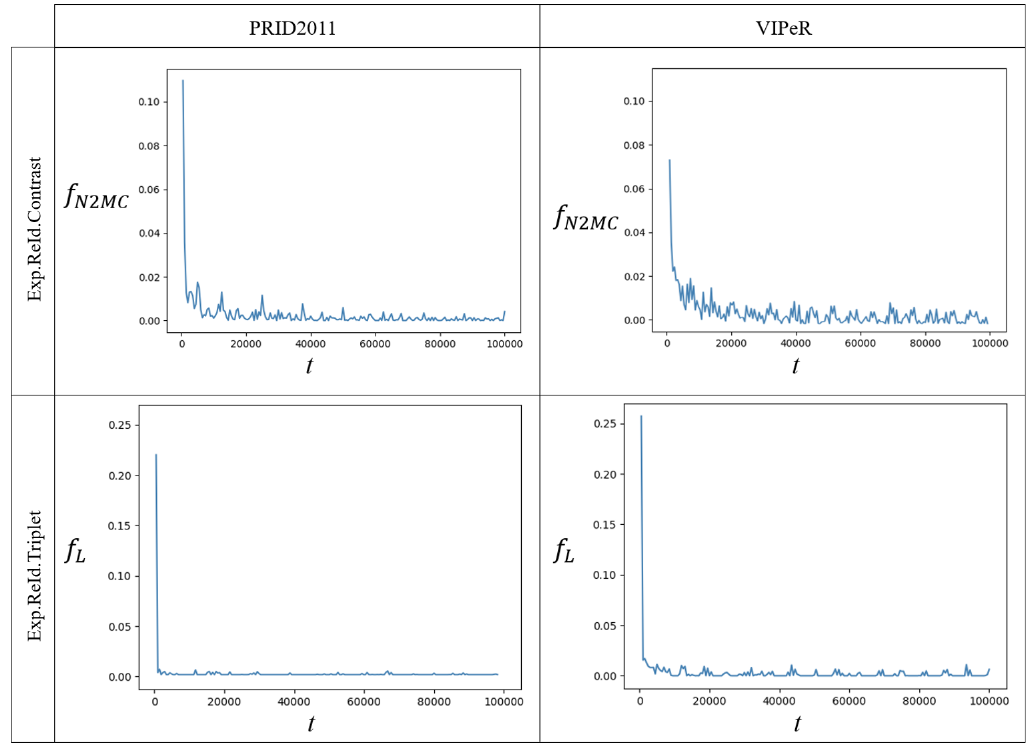
Figure 11. Learning curves of training with Double-Margin-Contrastive and Triplet loss over PRID2011 and